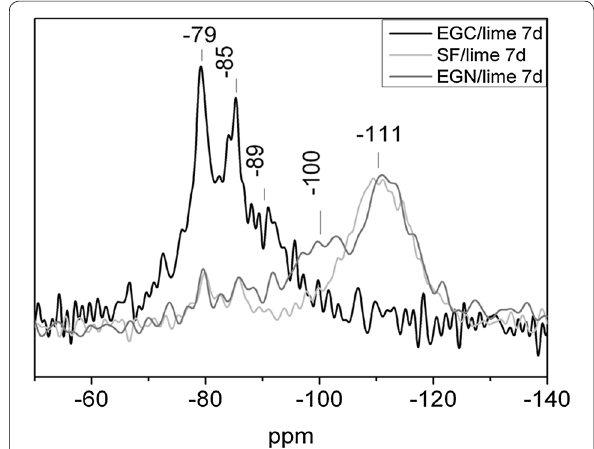
Fig. 3 29 Si NMR spectra for three 7‑day pozzolan/lime composites.